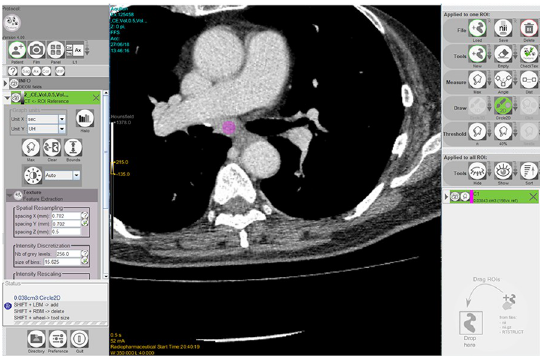
Fig 3. An example of texture analysis performed by the software. The open-source software (LIFEx) performed texture analysis of a 10-mm-diamter circular region of interest (colored pink), which was placed in the center of the targeted lymph